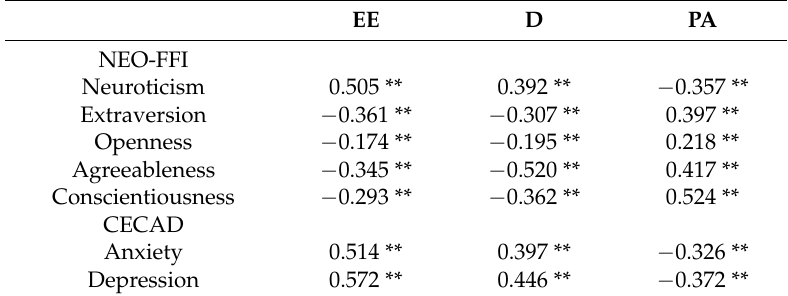
Table 4. Correlation coefficients between psychological variables and